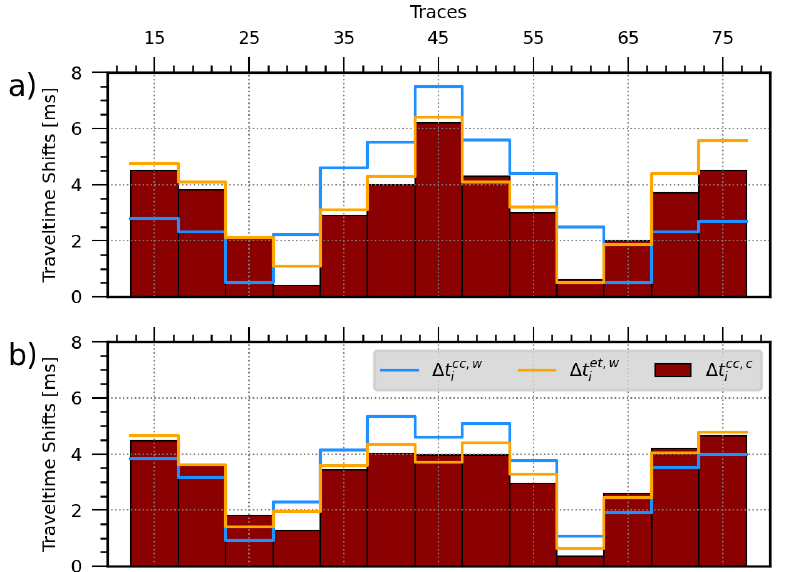
Figure 5. ( a , b ) show the comparisons of absolute travel-time shifts for P- and S-waves, respectively. The blue lines indicate the travel-time shifts ∆ t cc , w obtained by cross-correlating the observed traces i with synthetic traces using the wrong source wavelet. The yellow lines indicate the travel-time shifts ∆ t et , w obtained by cross-correlating the envelopes of the observed traces with envelopes of i the synthetic traces using the wrong source wavelet. The red bars indicate the travel-time shifts ∆ t cc , c obtained by cross-correlating the observed traces with the synthetic traces using the correct i source